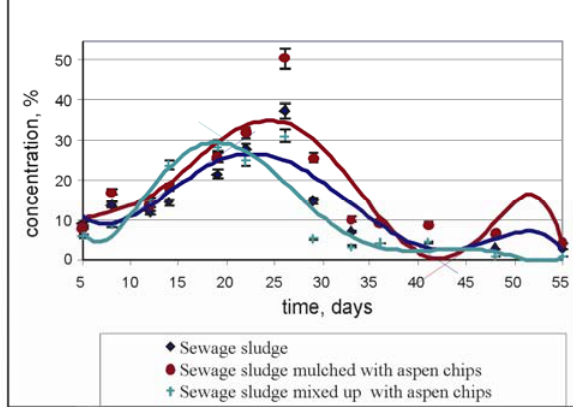
Fig. 10. Methane emissions during composting of sewage sludge with aspen